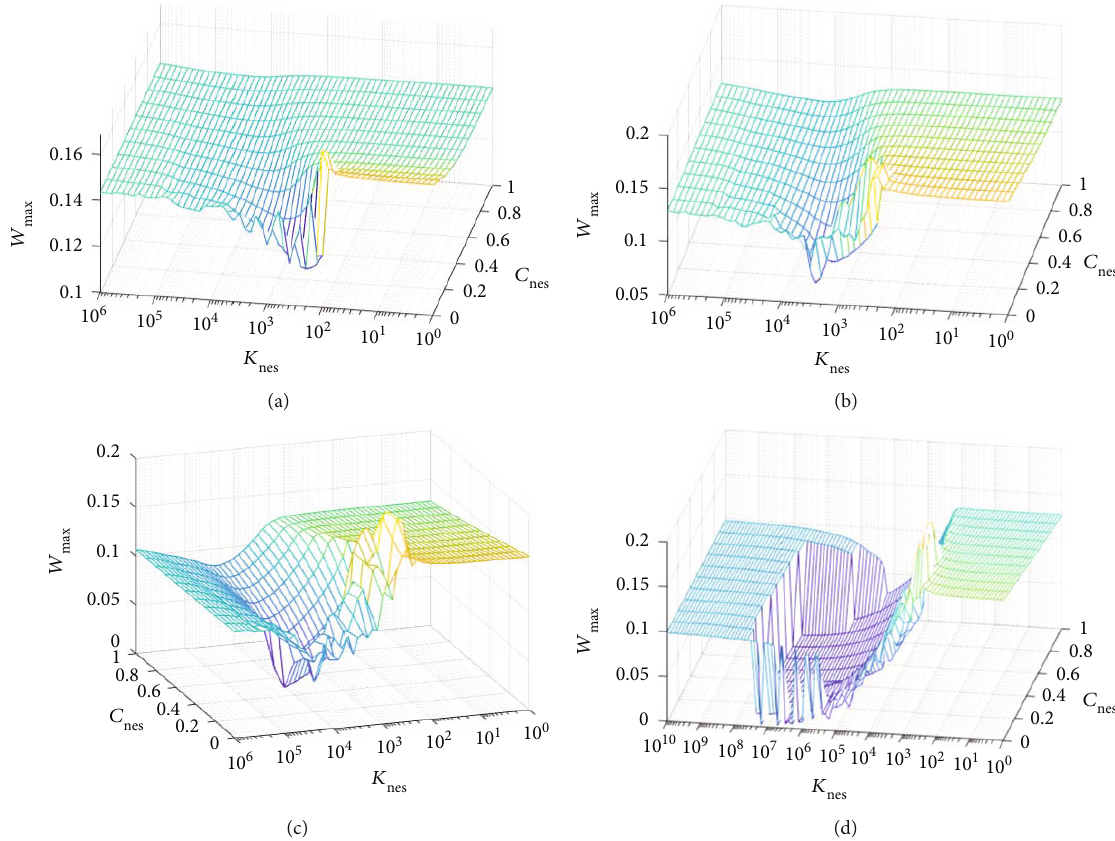
Figure 14: E ff ects of sti ff ness and damping coe ffi cients for di ff erent masses: (a) 0.01, (b) 0.02, (c) 0.03, and (d) 0.04.